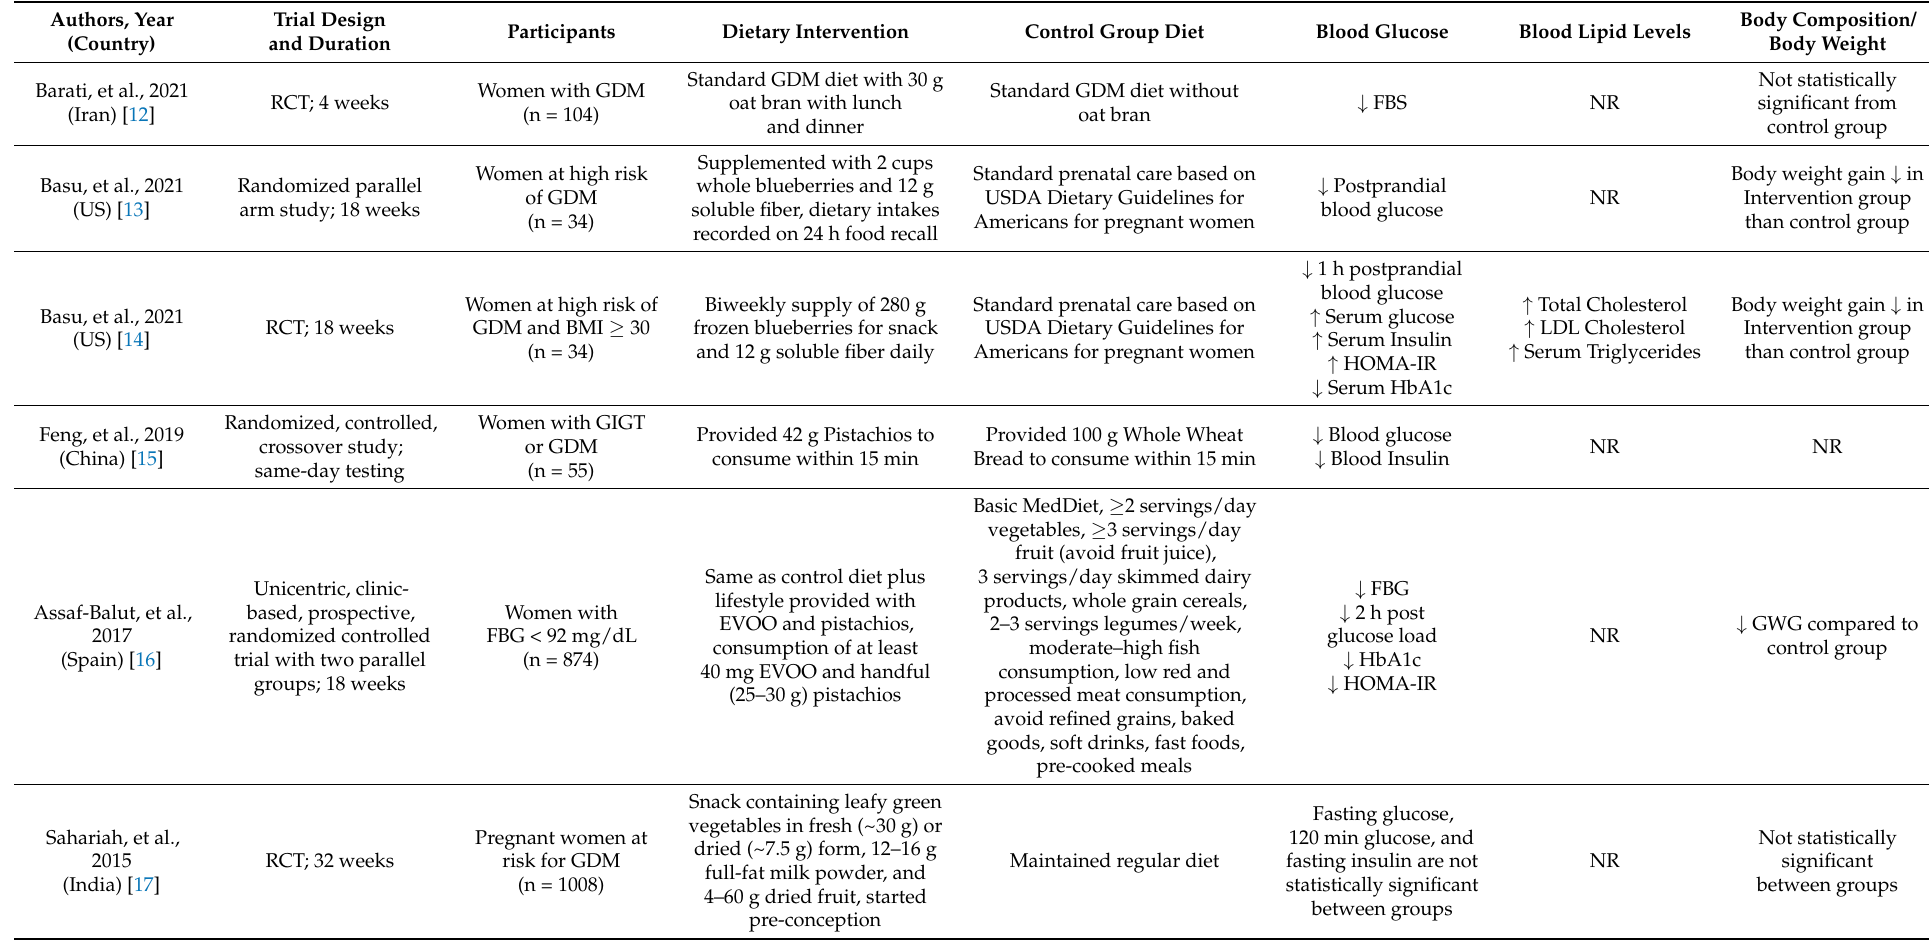
Table 1. Clinical trials on plant-based diets and food groups and their effects on gestational diabetes mellitus risks and